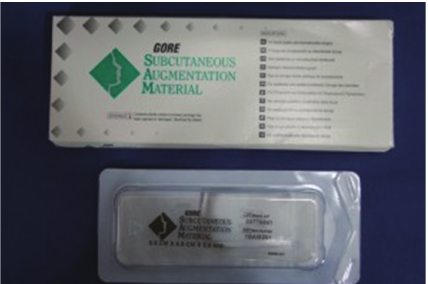
Figure 1: GORE-TEX.